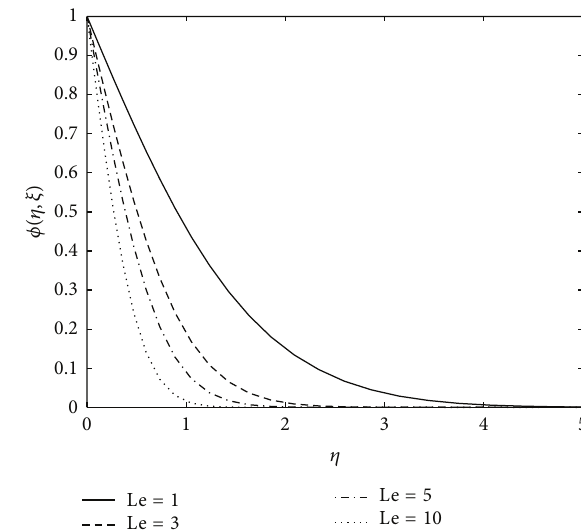
Figure 5: Effect of the Lewis number on the concentration